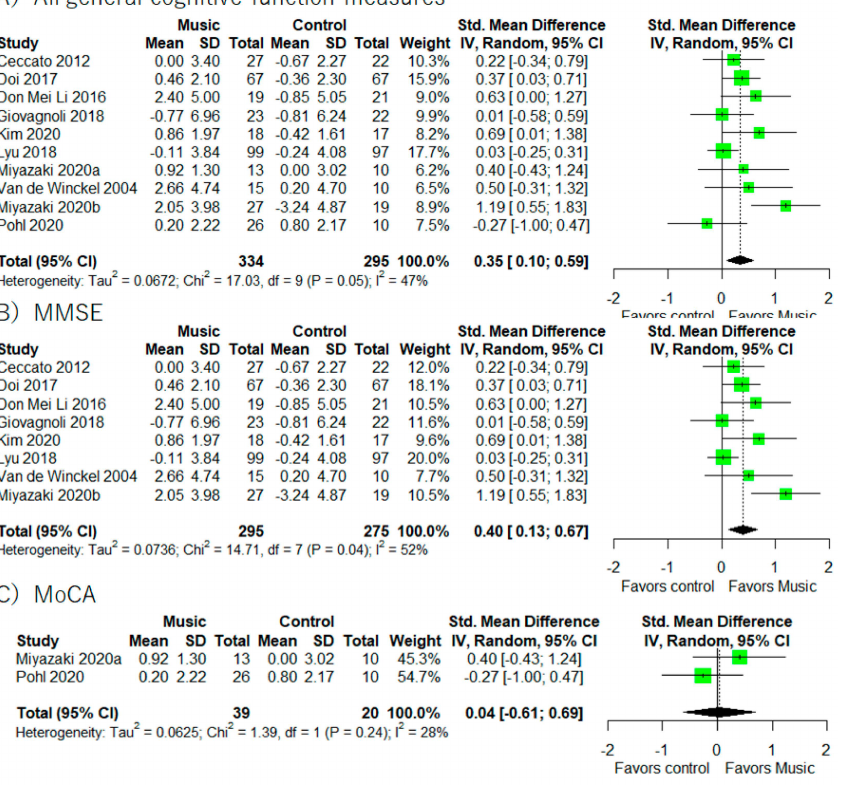
Figure 2. Trial level data, effect estimates, and forest plot for all general cognitive functions’ measures ( A ), MMSE ( B ), and MoCA ( C ). The area of green square is proportional to the study’s weight in the